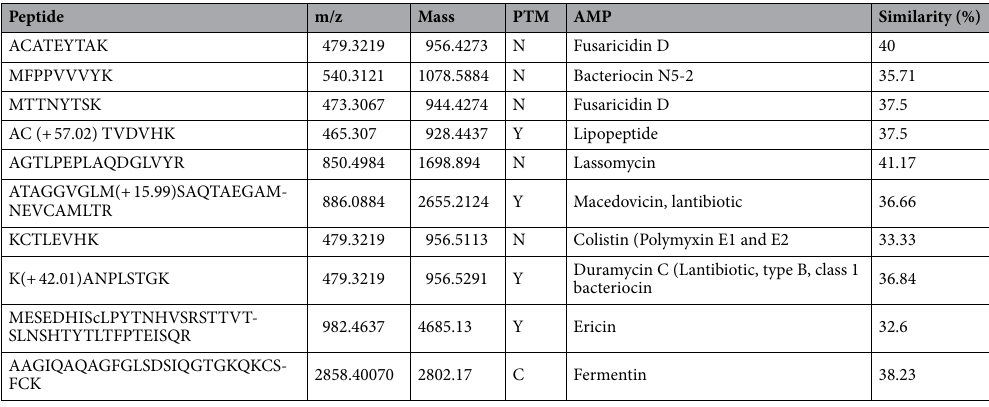
Table 1. The peptide sequences, masses, m/z, PTM, and their similarity percentage with the known peptide. The AMP sequences of the P. peoriae IBSD35 which have putative BGCs in the genome were generated using